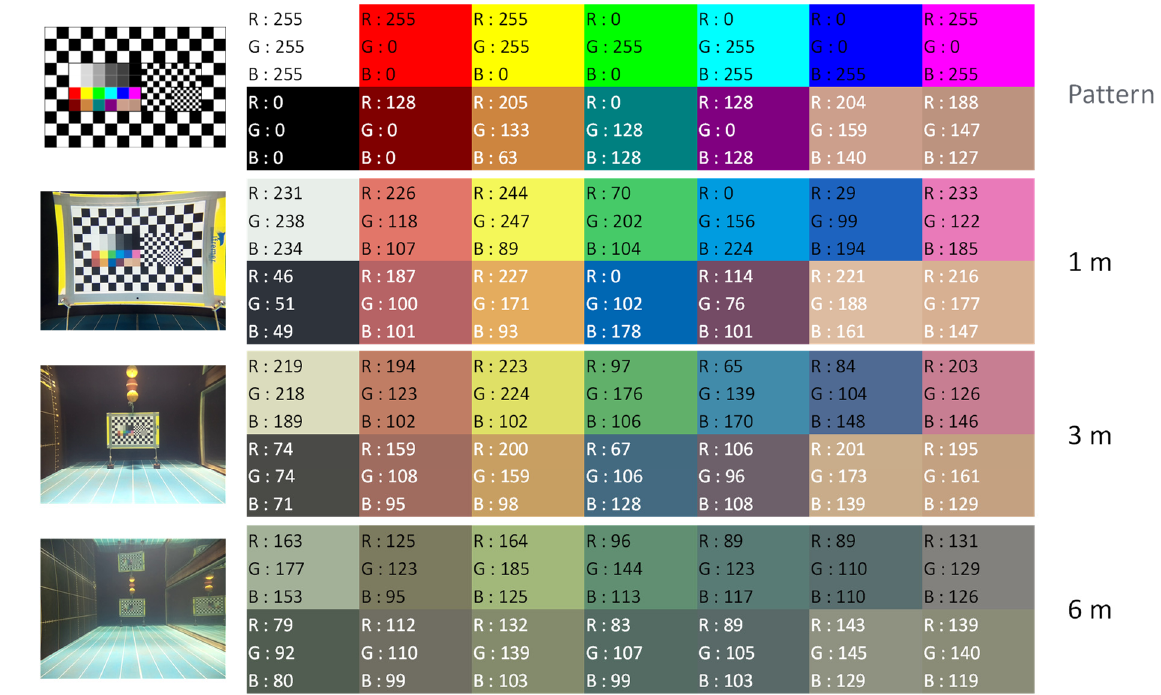
Figure 11. KOSMOS RGB coefficients at distances of 1, 3, and 6 m. Top: RGB coefficients for test pattern.